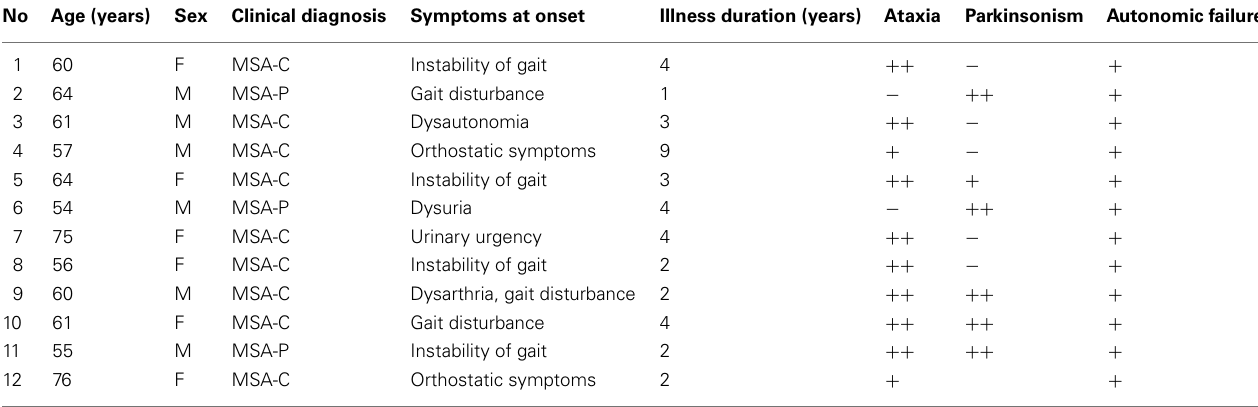
Table 1 | Clinical characteristics of multiple system atrophy (MSA) patients.